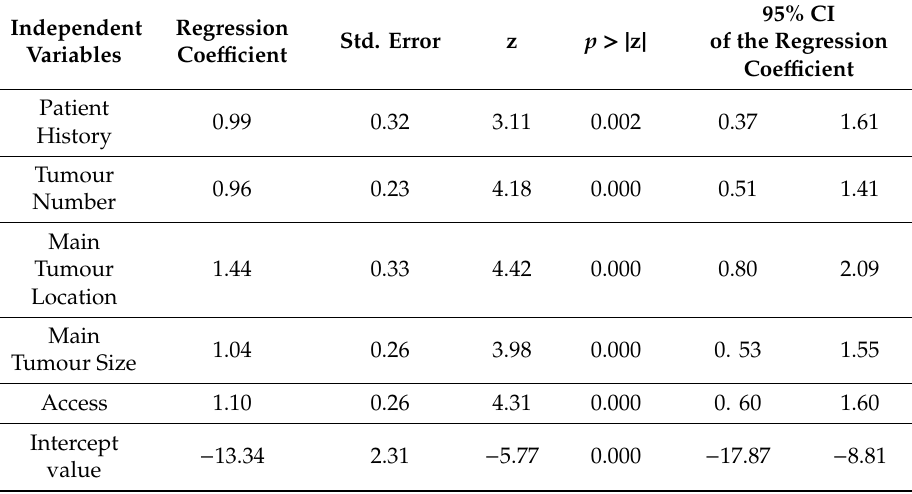
Table 2. Logistic regression analysis showing independent relationships between the complexity of TURBT and patient history, tumour number, main tumour location and size and factors restraining the access to the bladder